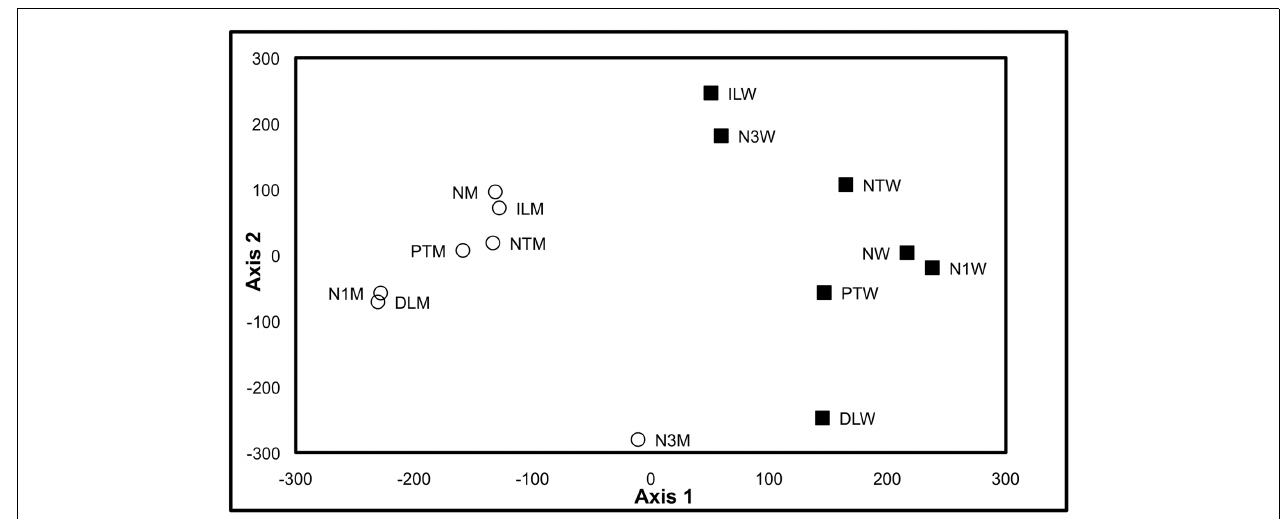
temperature change (PTW and PTM), negative temperature change (NTW and NTM), decreased light intensity (DLW and DLM), increased light intensity (ILW and ILM), 1h harvest delay (N1W and N1M), and 3h harvest delay (N3W and N3M).This plot indicates that the metabolomes of the wild-type samples and mutant samples can be differentiated even though environmental growth conditions were perturbed beyond the normal limits of the standard growth conditions defined in the Section “Materials and Methods.”